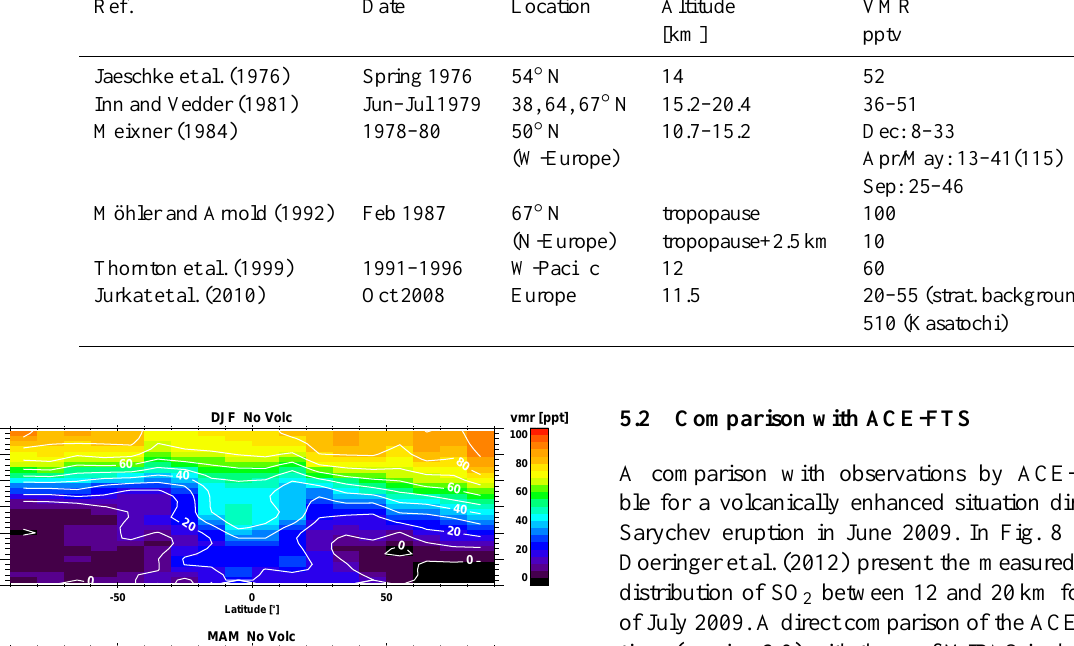
Table 1. In situ observations of SO 2 in the lower stratosphere. Ref.